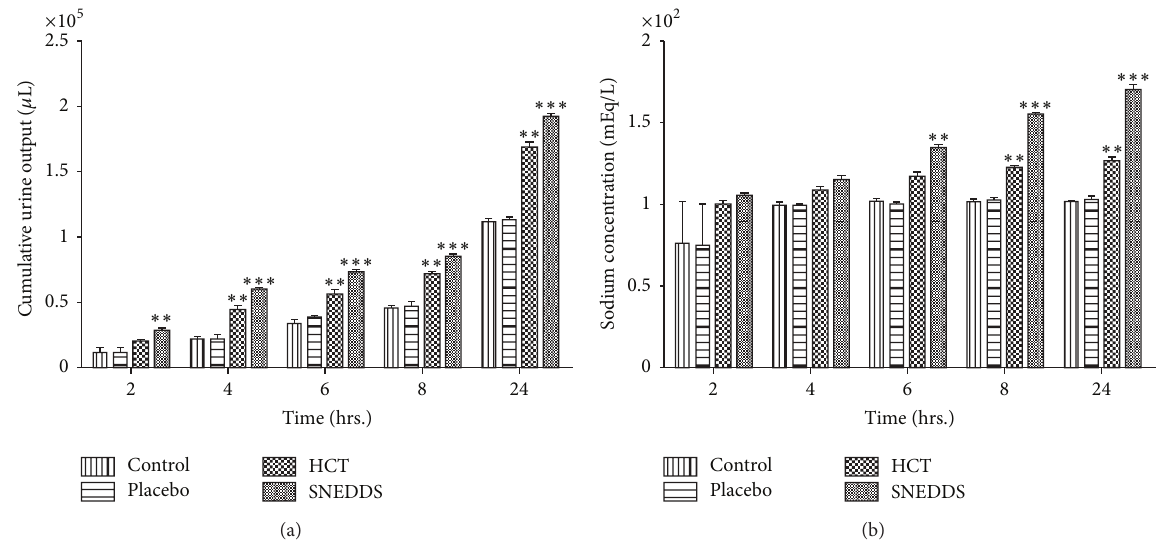
Figure 6: Time course of (a) urine output and (b) sodium output in different groups. Values are reported as mean ± S.E.M. for twelve rats in each group. ∗∗ Statistically significant from control and placebo group. 𝑃 < 0.05 . ∗∗∗ Statistically significant from control, placebo, and HCT group. 𝑃 < 0.05